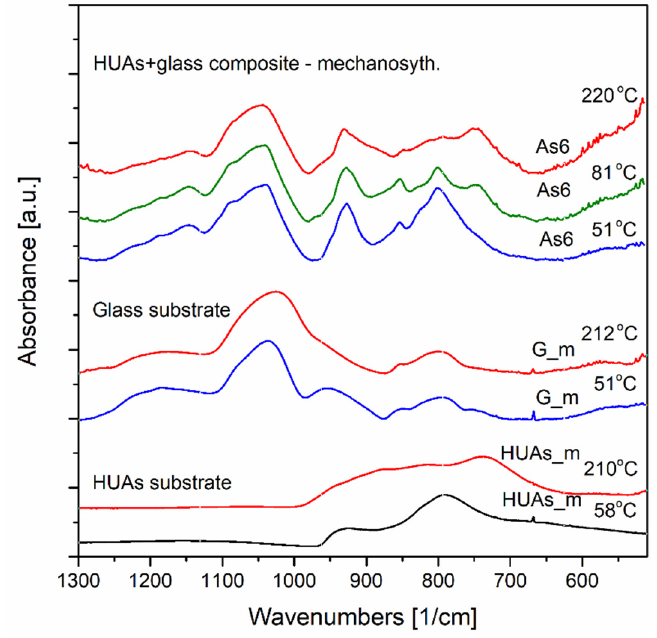
Figure 11. FTIR-ATR spectra of As6 composite samples (40% Gm + 60% HUAs) and their substrates: (HUAs) (UO 2 )(HAsO 4 )(H 2 O) 4 ) and Gm-milled 30P 2 O 5– 70SiO 2 glass. Spectra were acquired at elevated temperatures, and the spectra were normed and shifted for clarity.